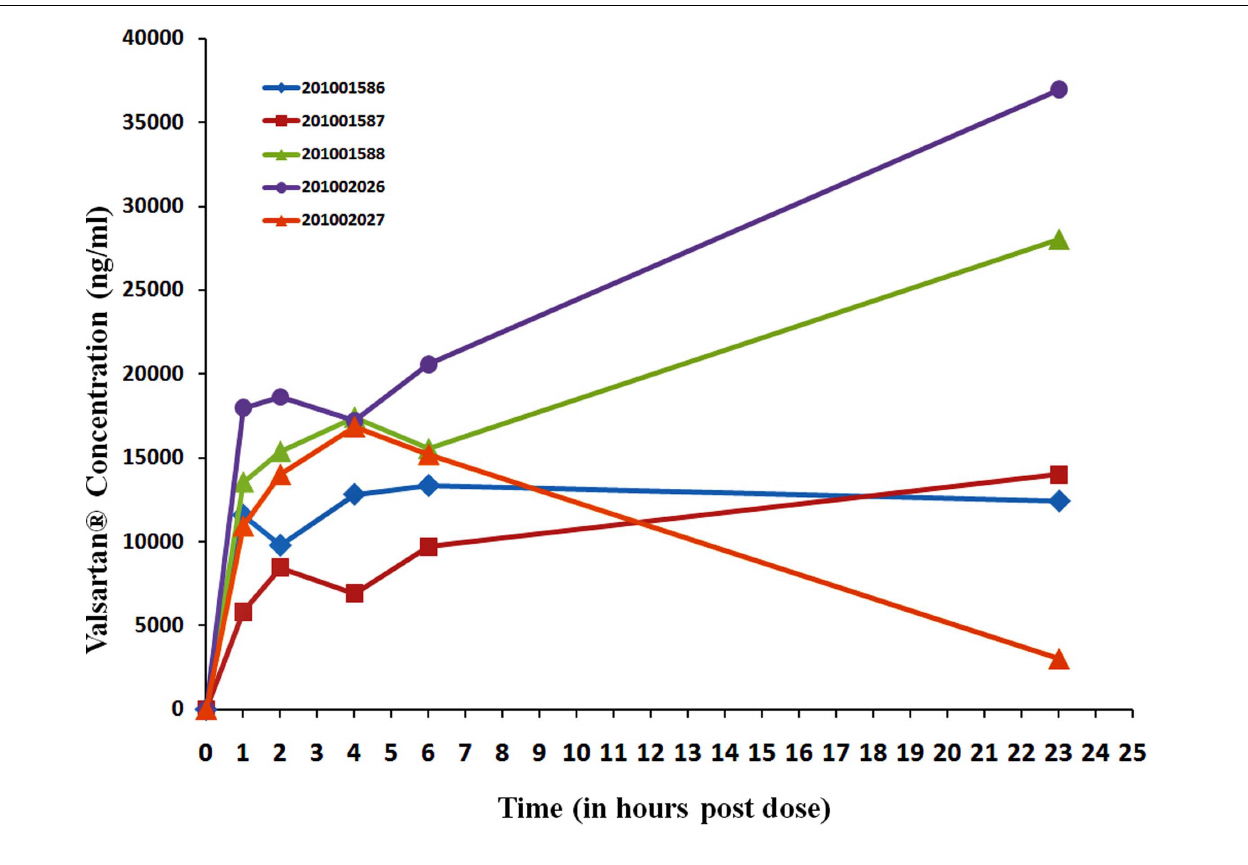
FIGURE 12 | Individual data for 30 μ I/hValsartan ® exposure.